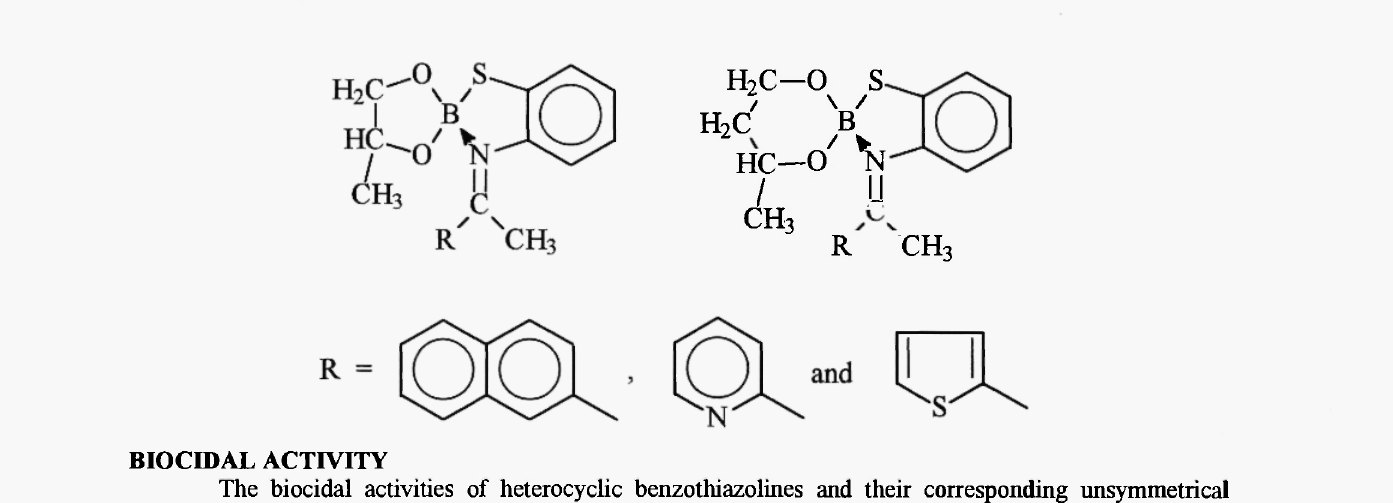
Table ΙΠ: Fungicidal Screening Data of Benzothiazolines and their Corresponding Borole Complexes (Average Percentage inhibition after 96 hours) Compound